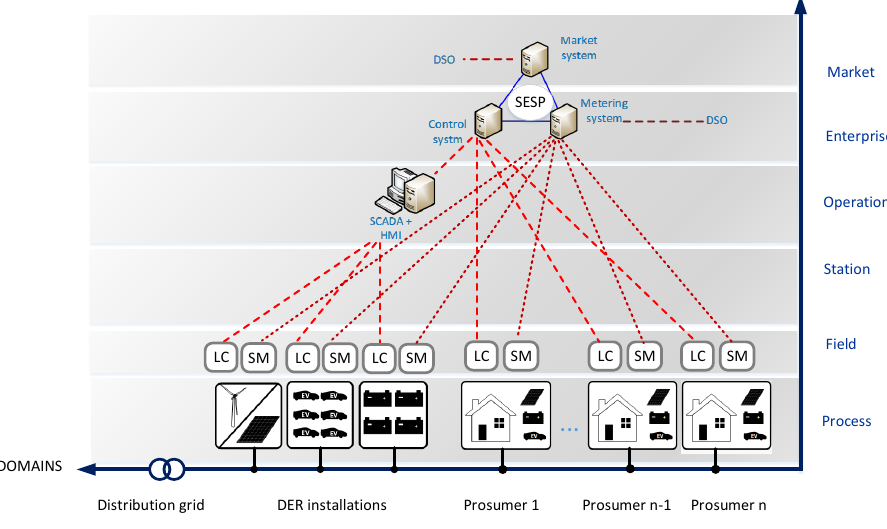
Figure 3. System architecture based on